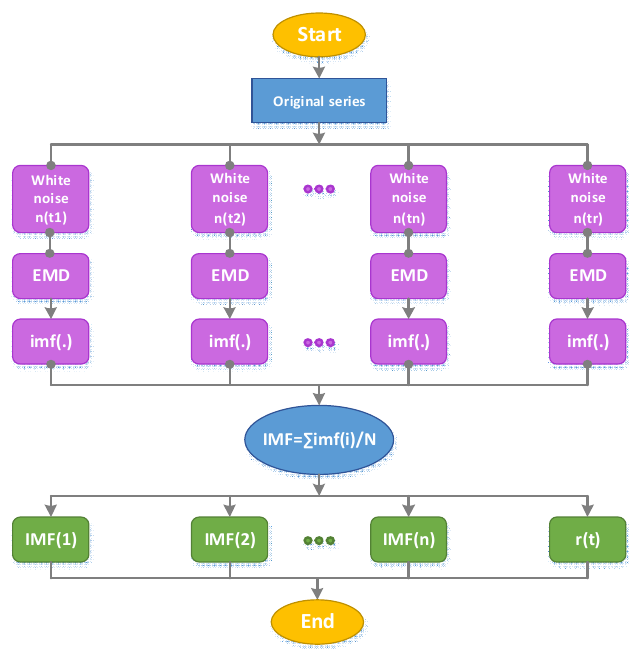
Figure 1. The process of Ensemble Empirical Mode Decomposition (EEMD). EMD, Empirical Mode Decomposition; IMF, Intrinsic Mode Function.